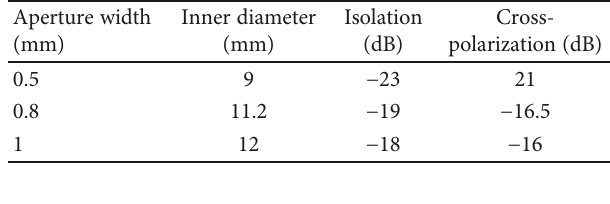
Table 1: Rule of the parameters of the aperture circle varies with the width of the aperture.